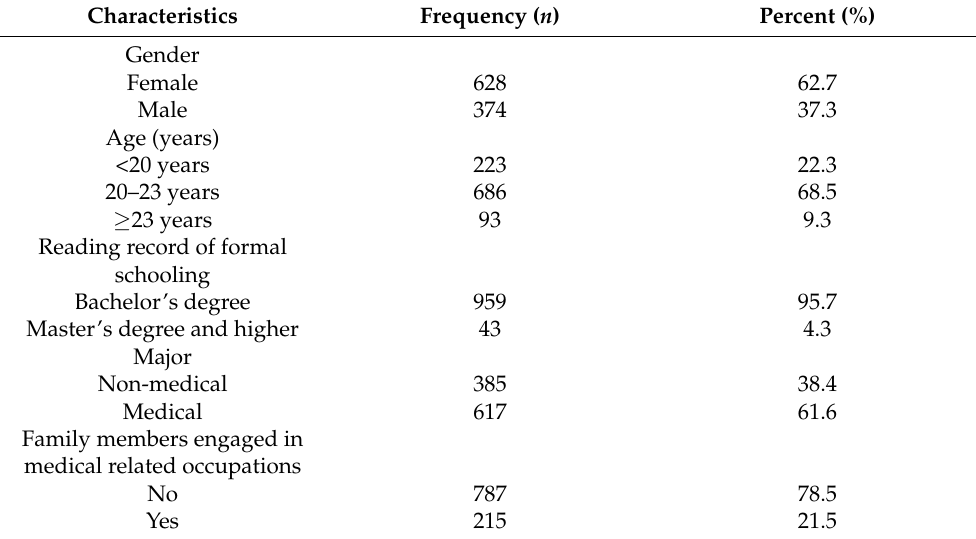
Table 1. Demographic characteristics of study participants ( n = 1002).